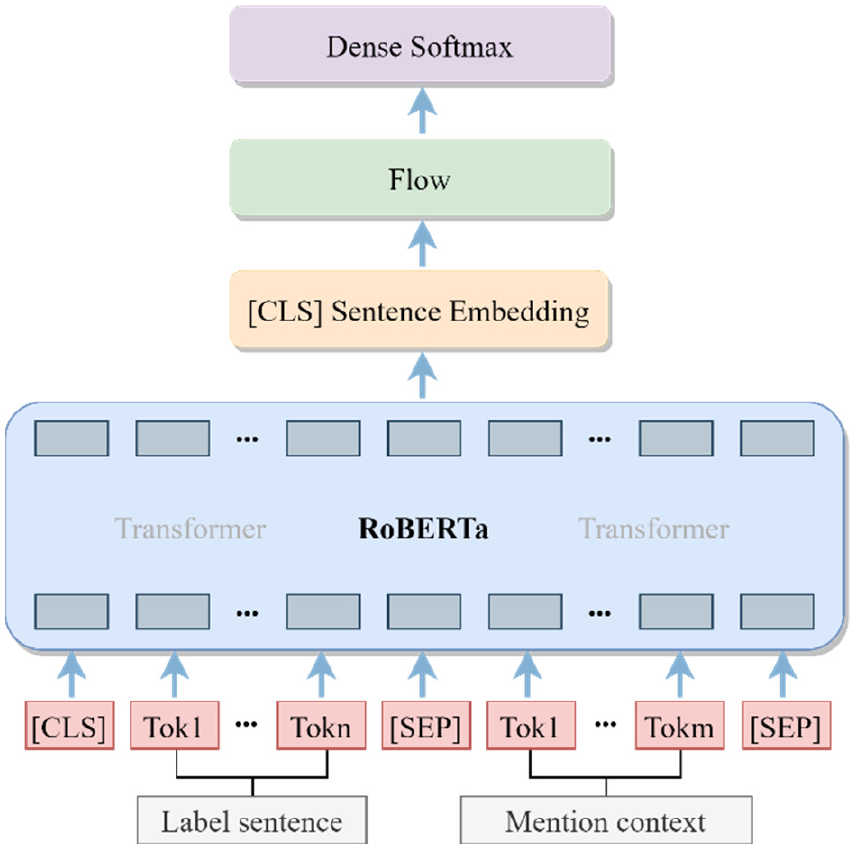
Figure 5. Entity ‐ typing model. Figure 5. Entity‑typing